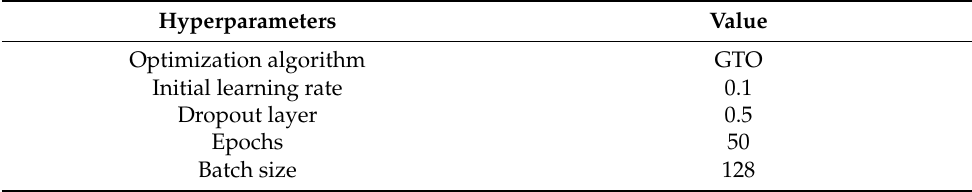
Table 1. Suggested model parameter settings.